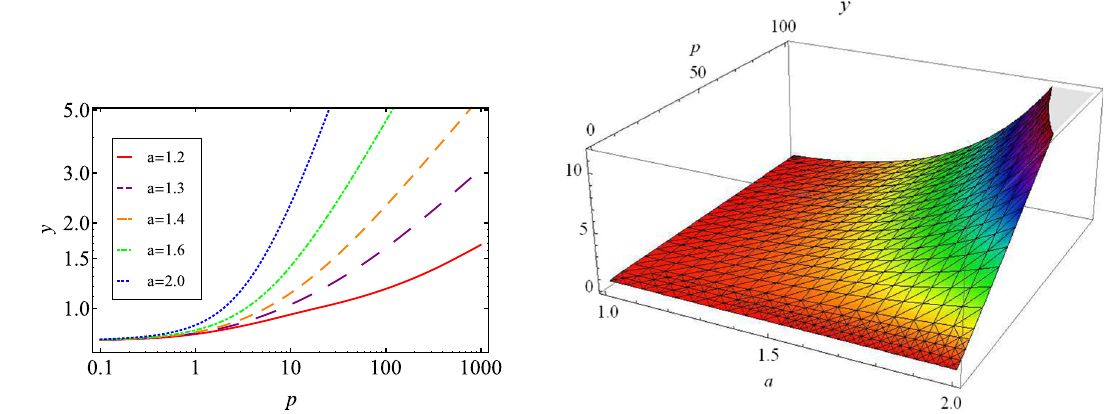
Fig. 5 The dependence of y on p for different a (see (88) in the range 1 < a ≤ 2. Left panel: two dimensional plot in logarithmic scale. Right panel: three dimensional plot